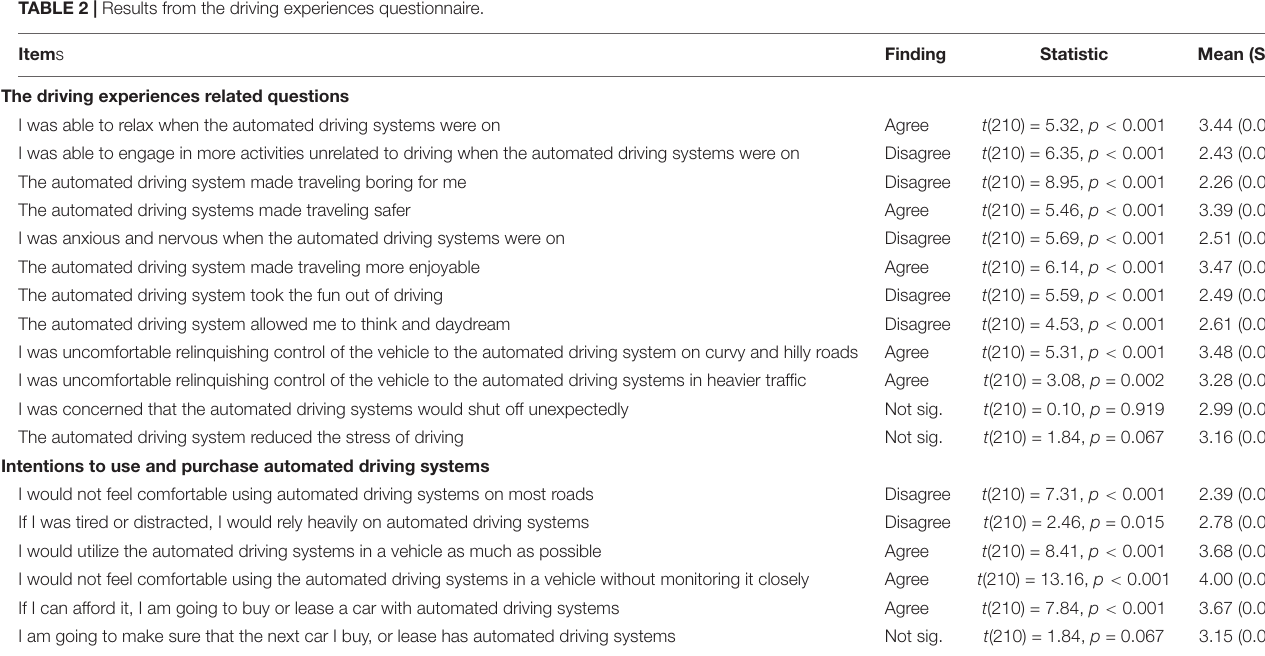
FIGURE 4 | The Bayesian values were plotted for the three outcome variables. A value less than 0.01 (shaded region) provides extreme evidence in favor of the null hypothesis (Lee and Wagenmakers, 2014). TABLE 2 | Results from the driving experiences